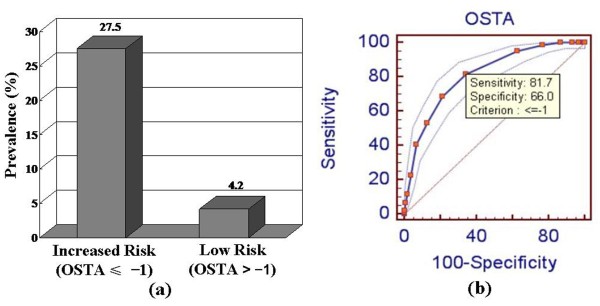
Relation of OSTA to the prevalence of new vertebral fracture in the increased risk group and low risk group according to the OSTA classification scheme. (a) Prevalence of new vertebral fracture by groups. (b) ROC curve.